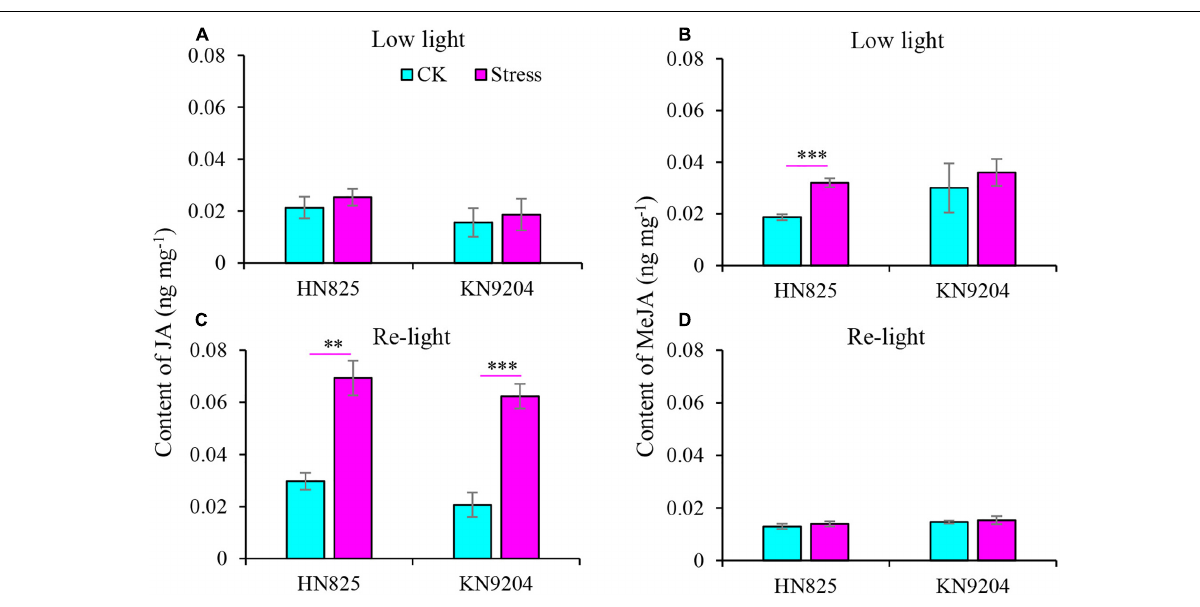
number per spike. The cross-pollination compensated